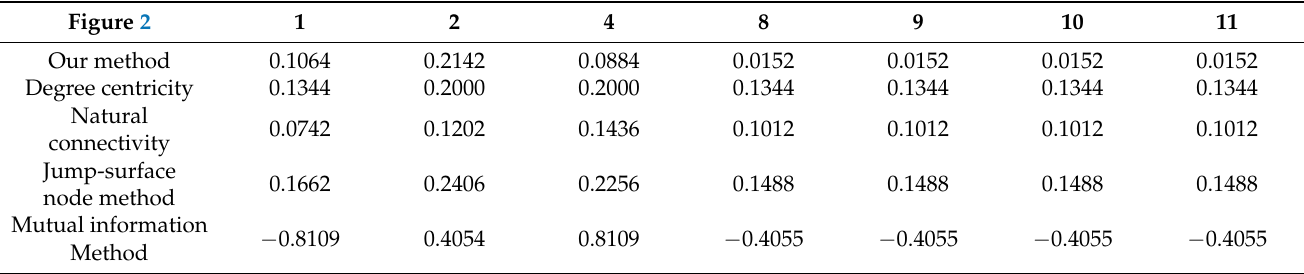
Table 4. Calculation results of node importance in Figure 2.